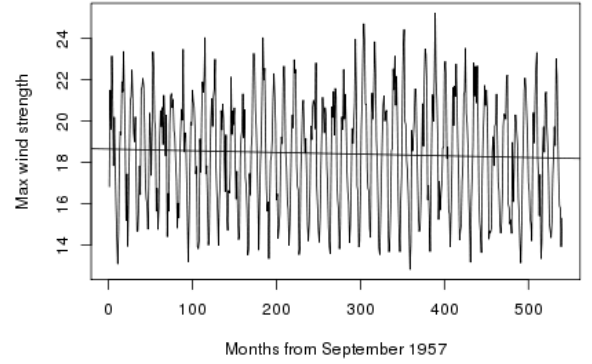
Fig. 3. The seasonality of the raw data